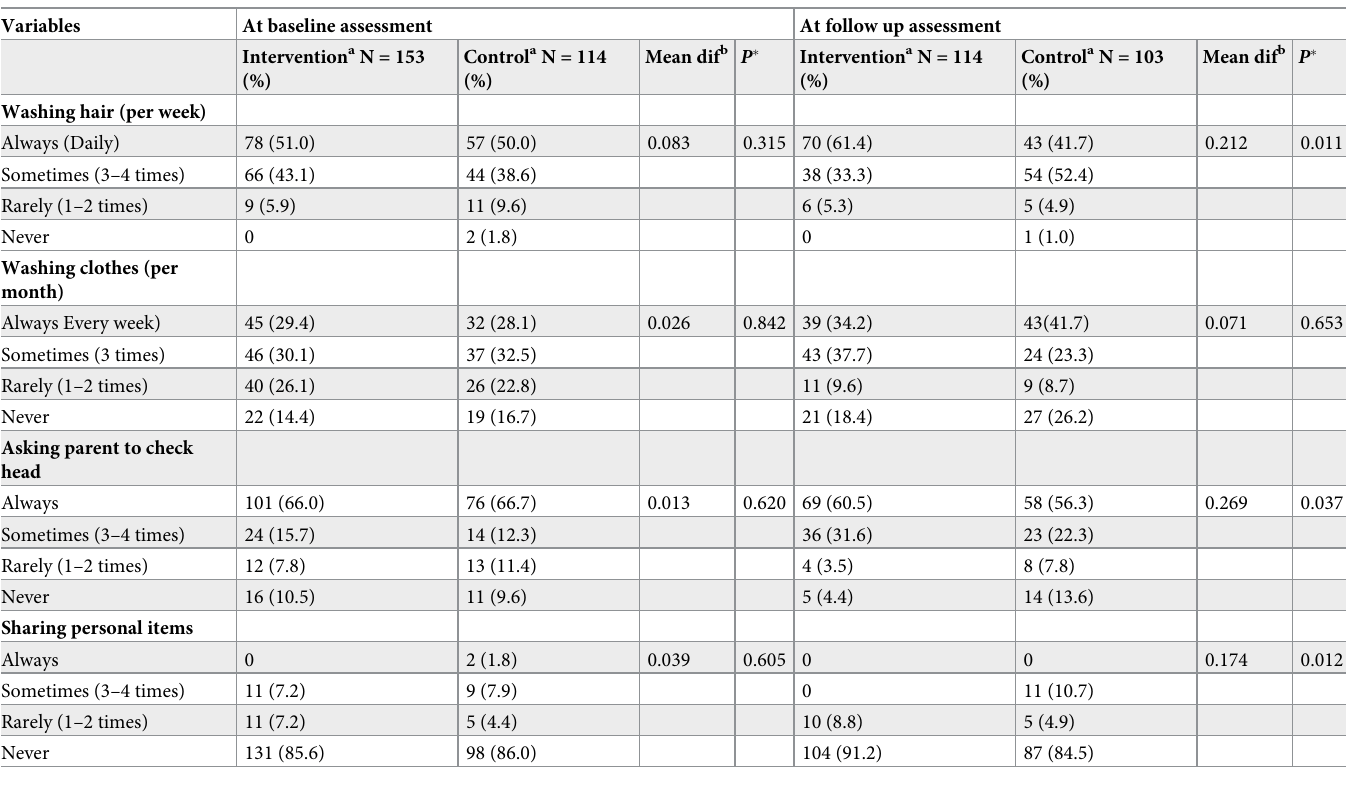
Table 5. The frequency of preventive practices in intervention and control groups at baseline and the two-month follow-up